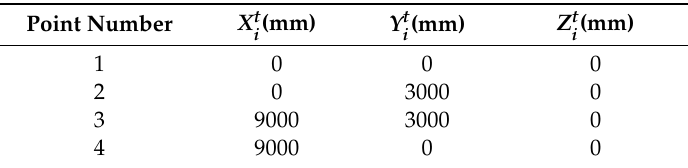
Table 2. Theoretical distances d t